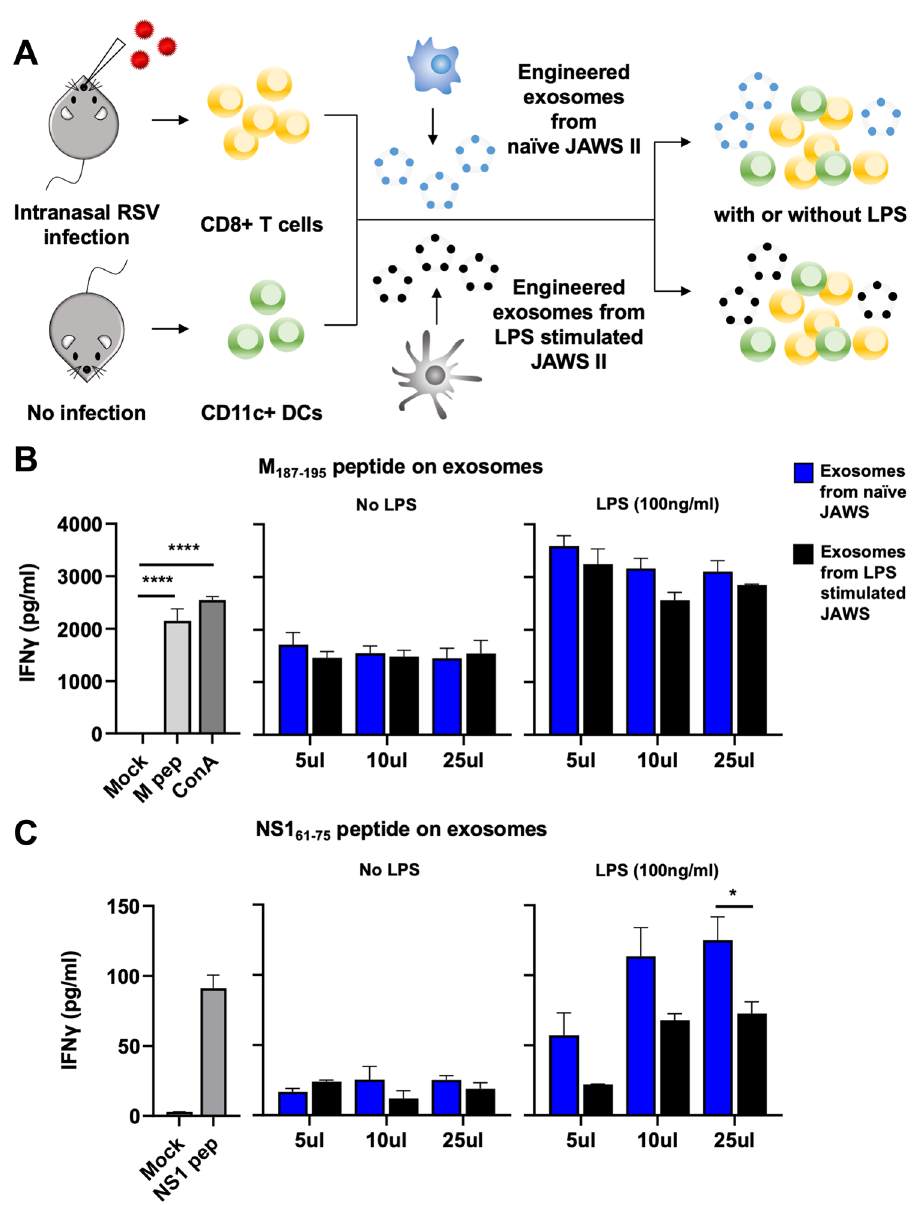
Figure 2. Engineered exosomes were immunogenic for activating RSV-specific CD8 T cells ex vivo. ( A ) Schematic illustration of the establishment of a DC-CD8 T cell co-culture model. C57BL/6J mice were infected intranasally with RSV strain A2 to generate RSV-specific CD8+ T cells. Magnetic-activated cell sorting (MACS) was used to sort CD8+ T cells from RSV-infected mice and CD11c + DCs from non-infected mice. CD8+ T cells and CD11c + DCs (5:3 ratio) were incubated for 72 h with escalating concentrations (5 μL, 10 μL, 25 μL) of exosomes engineered with M 187–195 or NS1 61–75 peptides with or without LPS (100 ng/mL). ( B , C ) Cell culture supernatants were collected on day 3 of stimulation with M 187–195 or NS1 61–75 engineered exosomes. The samples were diluted 1:4 and analyzed by commercial ELISA for IFN-γ. Data represent means ± SEM. ****p < 0.0001 as determined by one-way ANOVA and Dunnett’s multiple comparisons test. *p < 0.05 as determined by two-way ANOVA and Šídák’s multiple comparisons